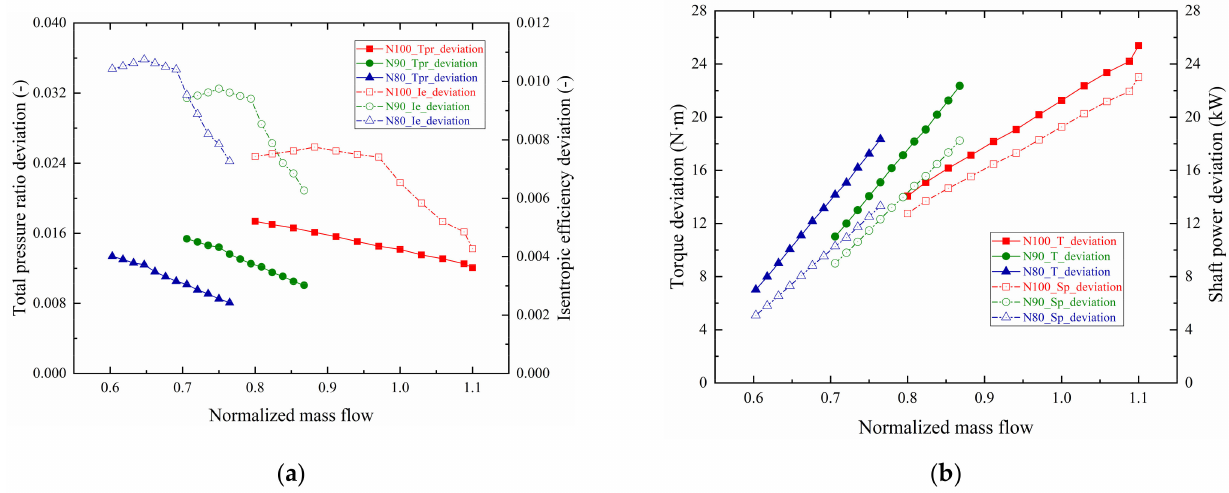
Figure 11. Effects of IBC on predicted aerodynamic performance parameters under variable rotating speeds: ( a ) PR t and η is ; ( b ) T and P s